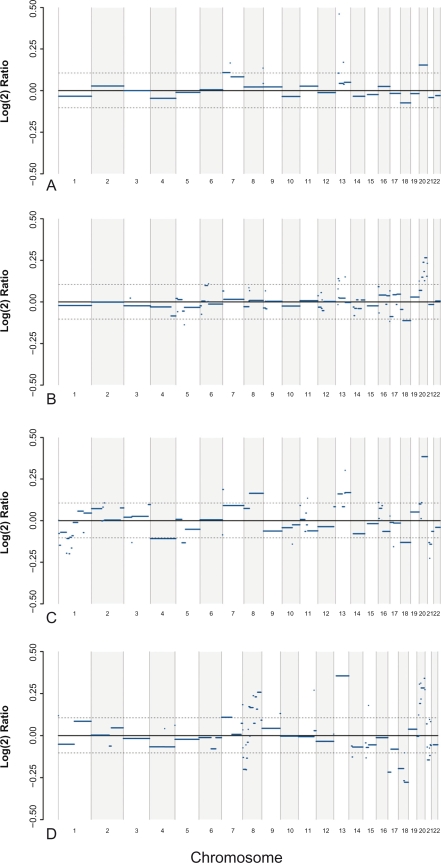
Genome wide overview of DNA segments with sequence variations across chromosomes in Dukes A, B, C and D. Solid lines outside or close to the confidence interval (dashed lines) suggest significant DNA sequence alterations.